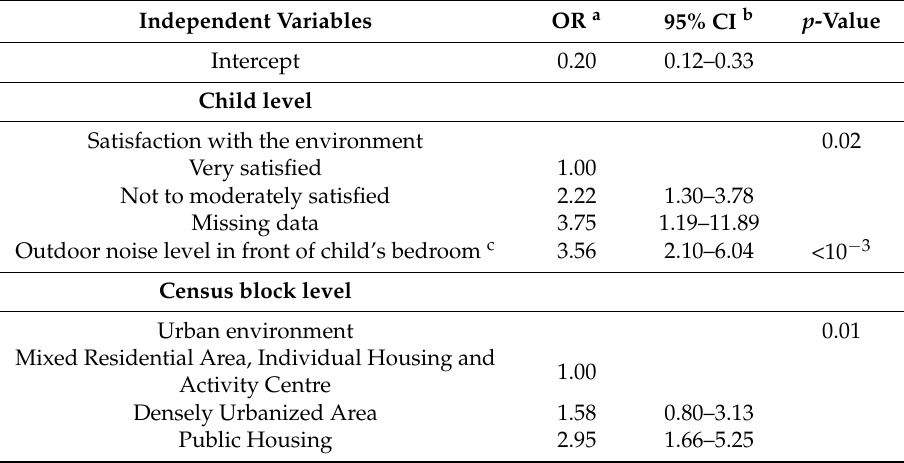
Table 4. Annoyance caused road traffic noise in children: multivariate